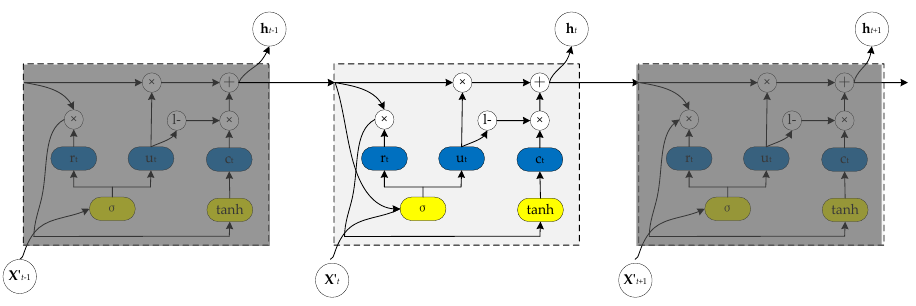
Figure 4. The schematic depiction of GRU for energy consumption prediction.